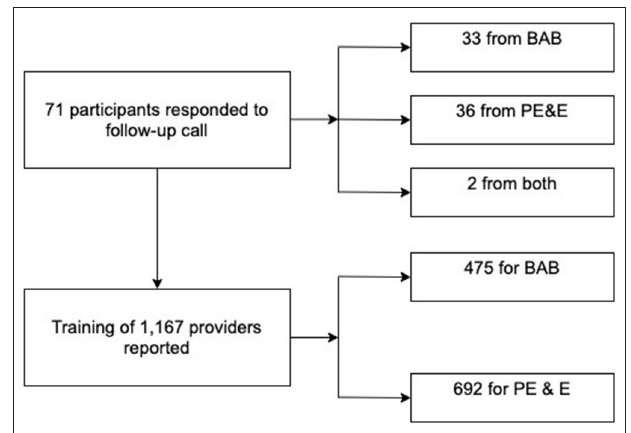
FIGURE 2 | Flow chart of follow-up responses and subsequent training.